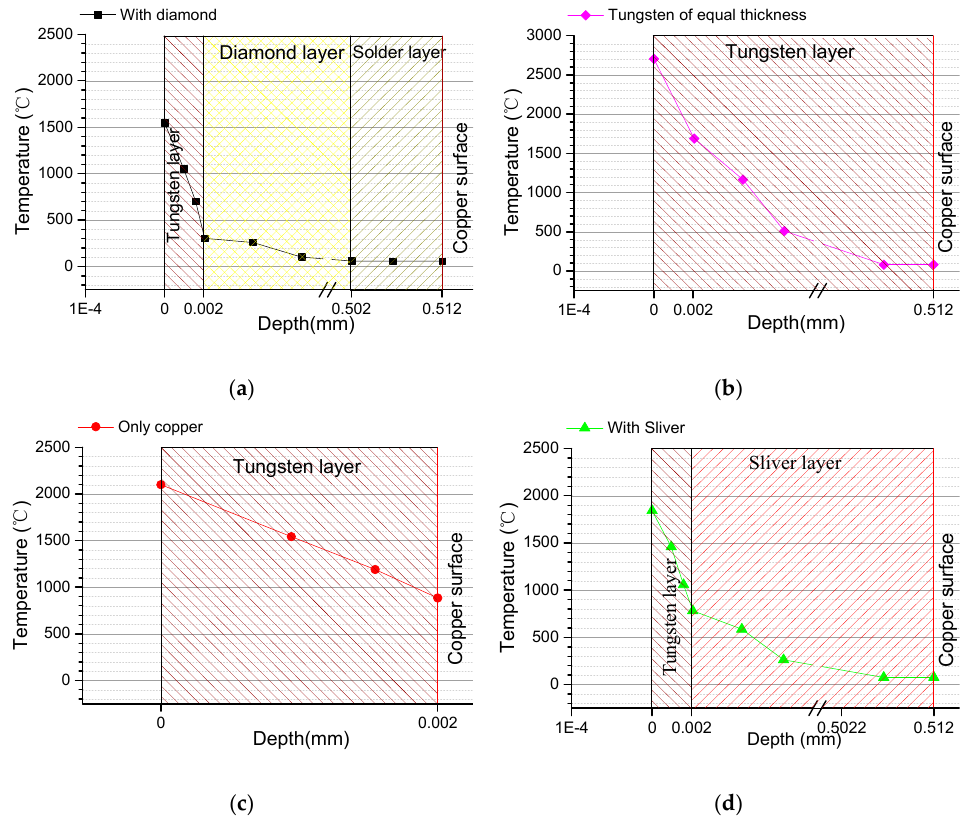
Figure 7. Comparison of vertical heat distributions at the focal spots between four types of anodes: ( a ) composite anode, ( b ) conventional tungsten anode, ( c ) tungsten film anode and ( d ) anode with silver heat buffer layer.